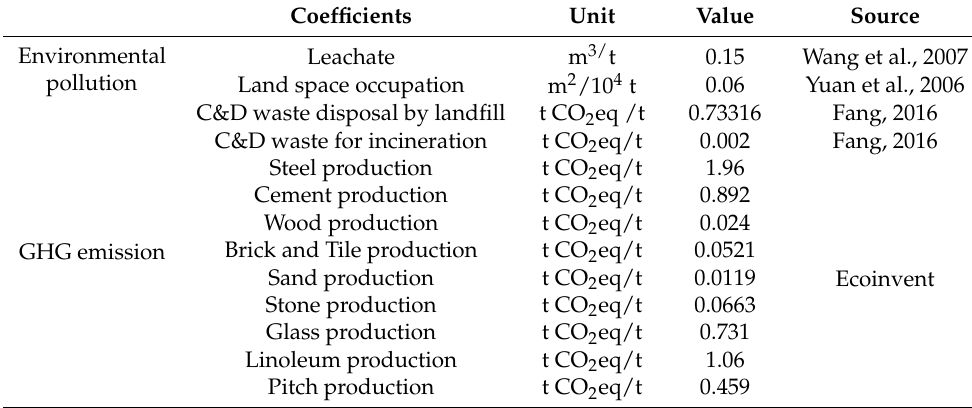
Table 3. Environmental and resource impacts’ coefficients of some variables.